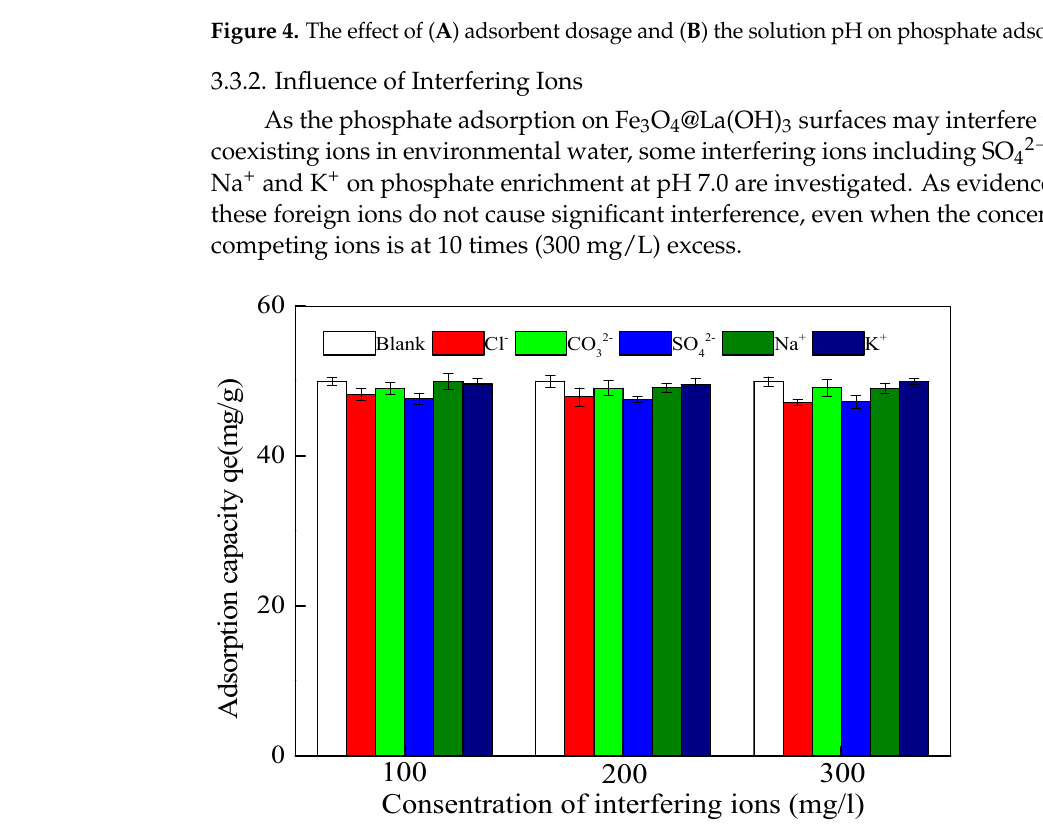
Figure 5. Adsorption capacity for phosphate in the presence of 30 mg/L phosphate and various concentrations of possible interference ions.